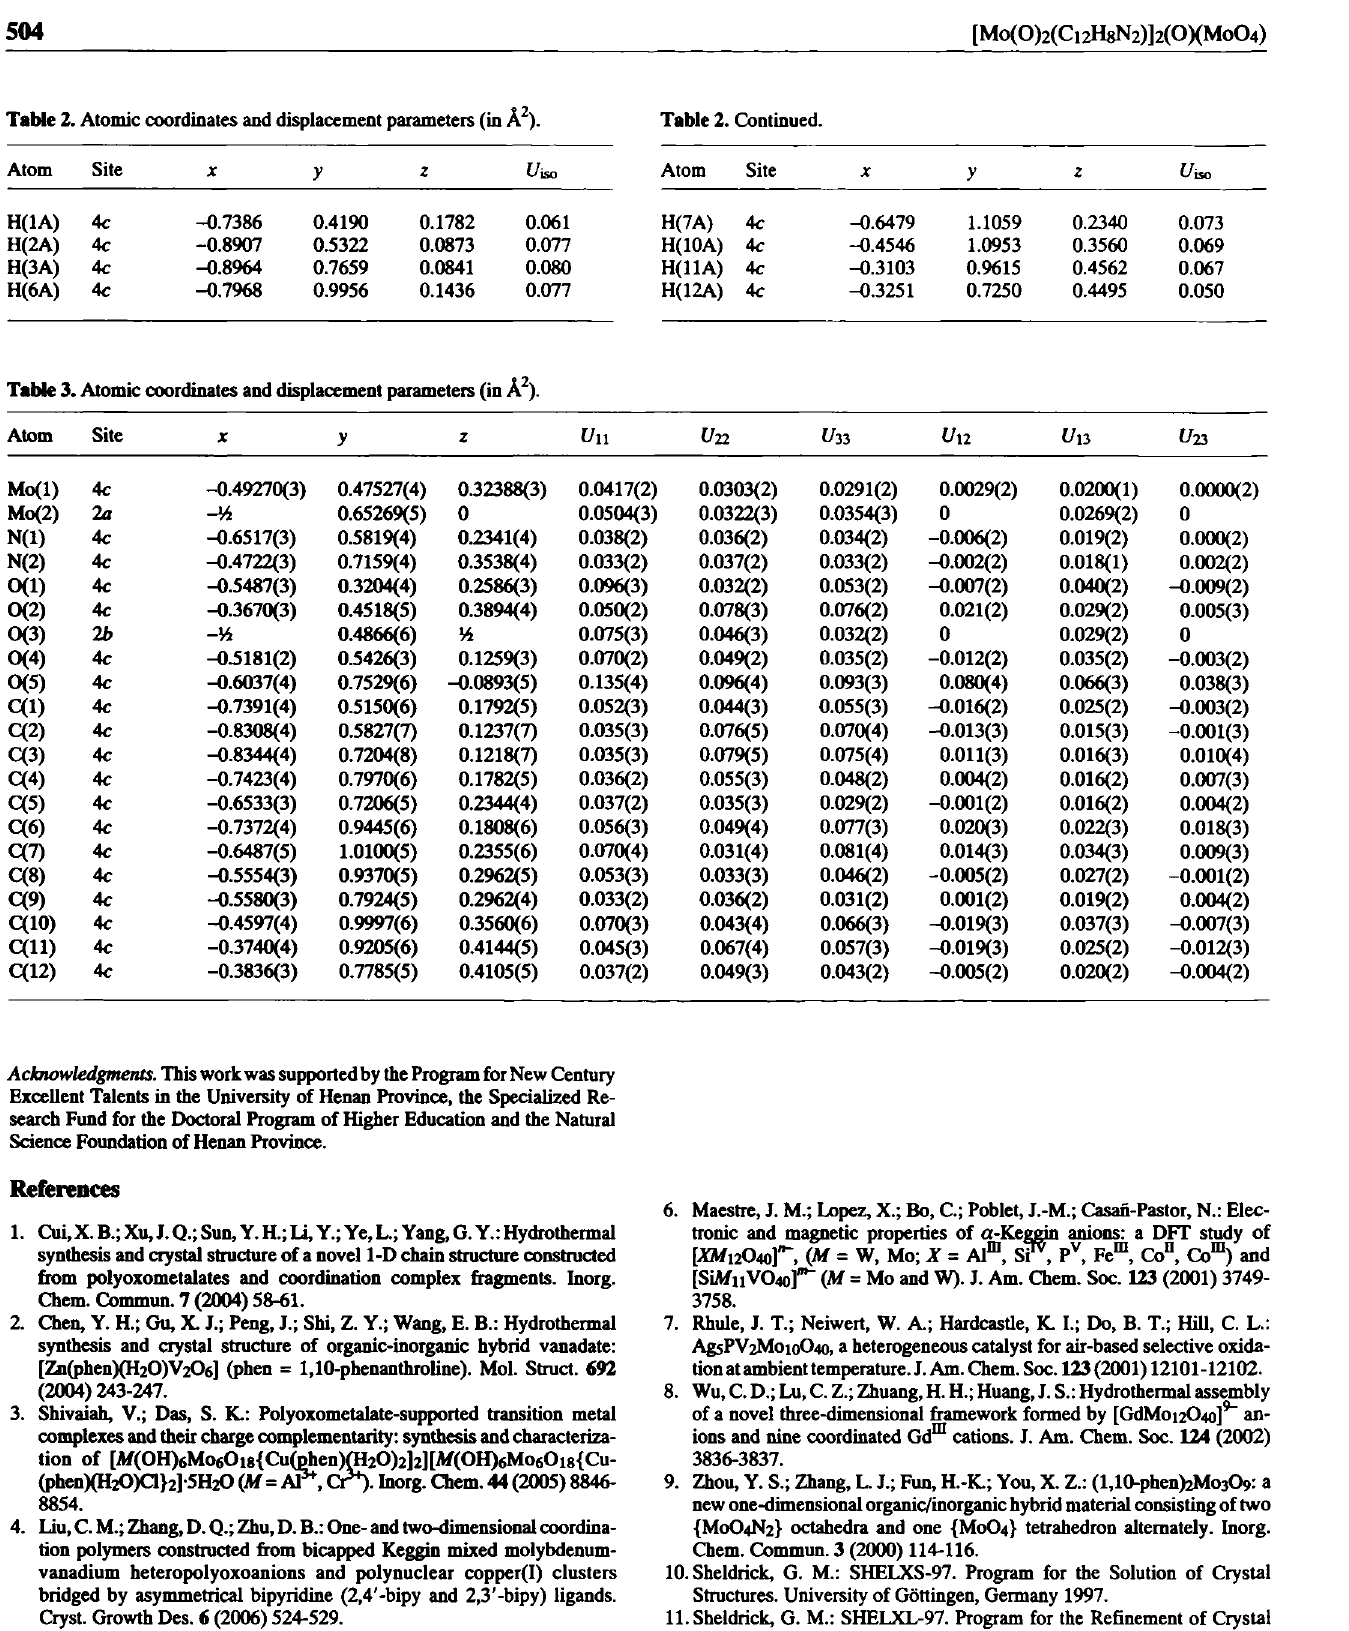
Table 2. Atomic coordinates and displacement parameters (in Ä 2 ). Table 2. Continued.